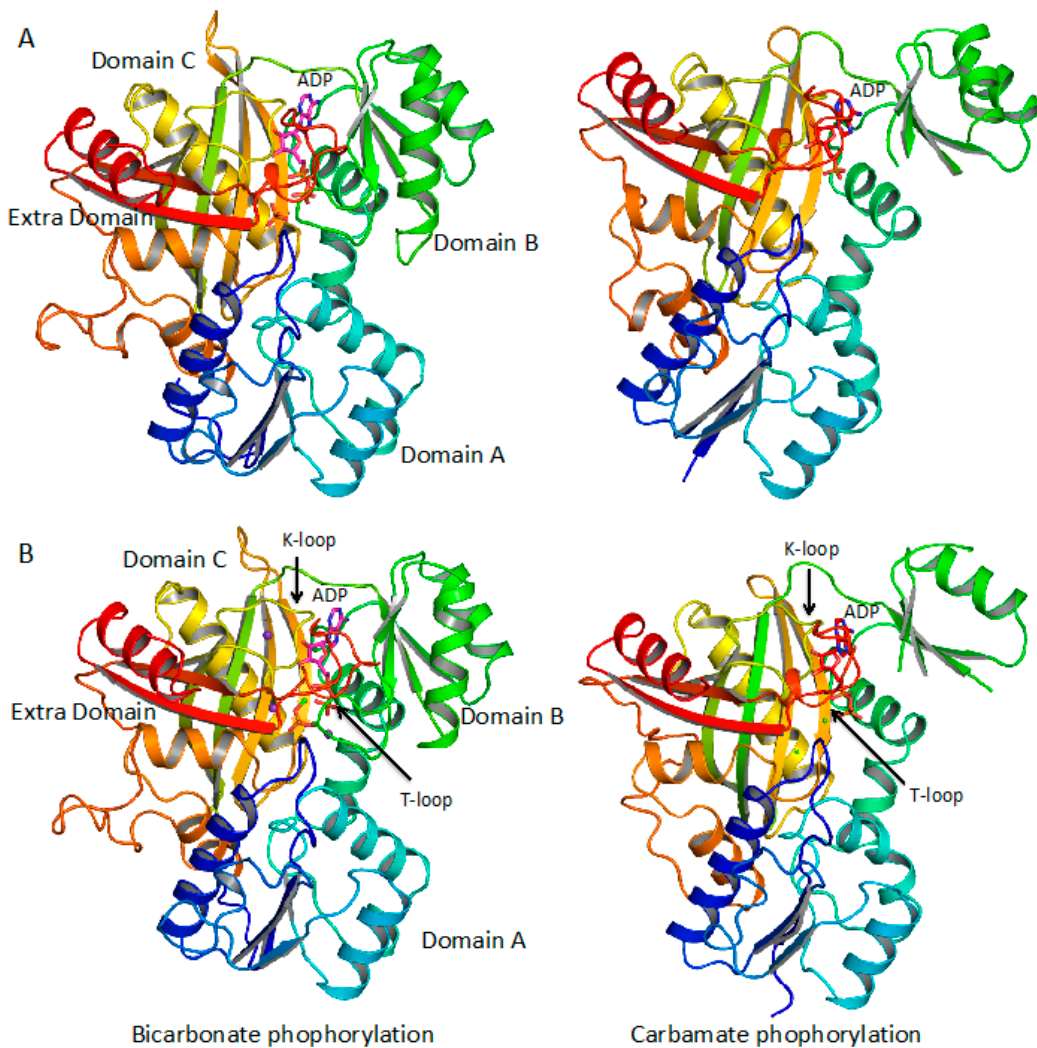
Figure 2. Ribbon diagram of the structure of A1 (bicarbonate phosphorylation) and B1 (carbamate phosphorylation) domains of E. coli CPS ( A ) (PDB ID: 1jdb) and human CPS I ( B ) (PDB ID: 5dou). Both bicarbonate phosphorylation domain and carbamate phosphorylation domain in E. coli CPS and human CPS I have very similar folds with A1 and B1 having the traditional ATP-grasp protein fold with the N -terminal domain (domain A) in blue to light blue, the central domain (domain B) in green, and the C -terminal domain (domain C) in yellow to brown. The K-loops (residues 654–662 and 1197–1205 in human CPS I and residues 237–245 and 782–790 in E. coli CPS) are corresponding to the ATP binding loops in ATP-grasp proteins. In comparison to the traditional ATP-grasp proteins, both the carbonate and carbamate phosphorylation domains have an extra domain (shown in red), which hosts a T-loop (residues 777–793 and 1314–1330 in human CPS I, residue 362–378 and 895–911 in E. coli CPS). The bound ADP shown in stick model is located at the cleft between domains B and C, and covered by the T-loop of the extra